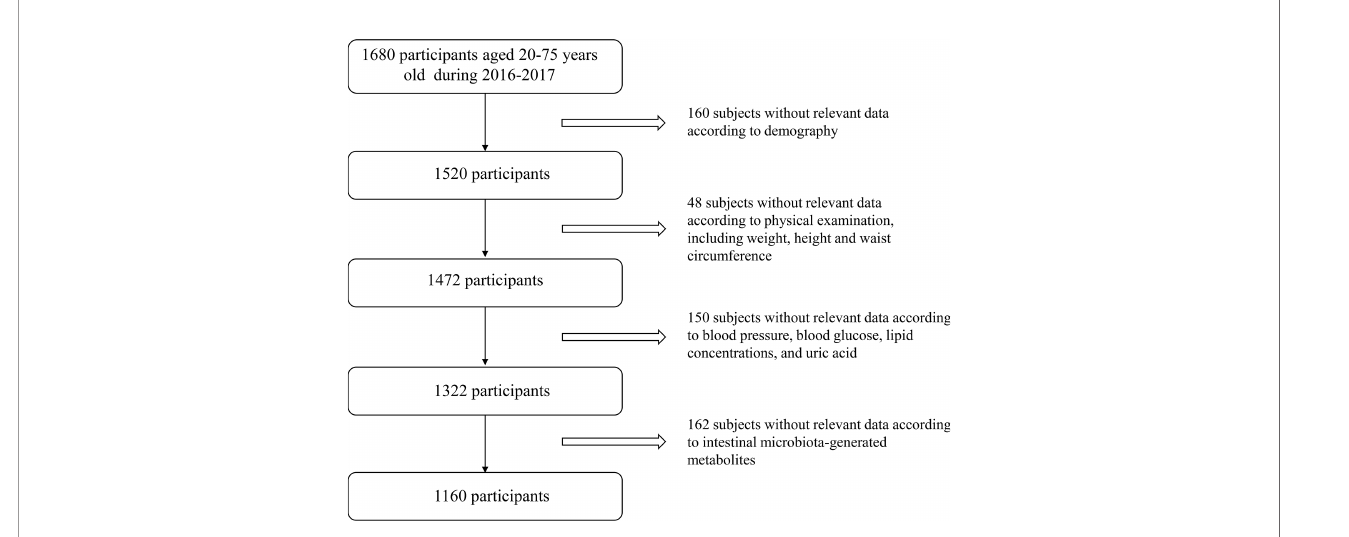
FIGURE 1 | Flow chart of the study